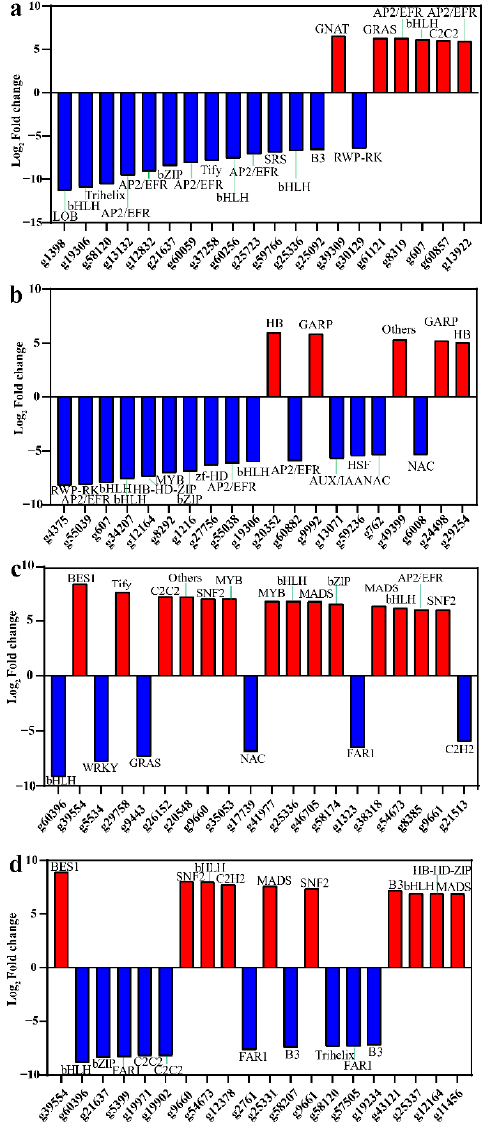
Figure 6. Differentially expressed genes encoding transcription factors in sweet potato samples. ( a – d ) The top 20 TF-encoding genes exhibiting the greatest fold-change in expression levels when comparing the BS-S2 and BS-S4 ( a ), S19-S2 and BS-S2 ( b ), S19-S2 and S19-S4 ( c ), and S19-S4 and BS-S4 ( d ) samples. 3.5. Identification of Transcription Factors related to Carotenoid Accumulation Transcription factors (TFs) and other transcriptional regulators (TRs) are key regula- tors of the expression of all genes, including those associated with the biosynthesis of ca- rotenoids. In this study, 284 (88 upregulated, 196 downregulated), 255 (58 upregulated,